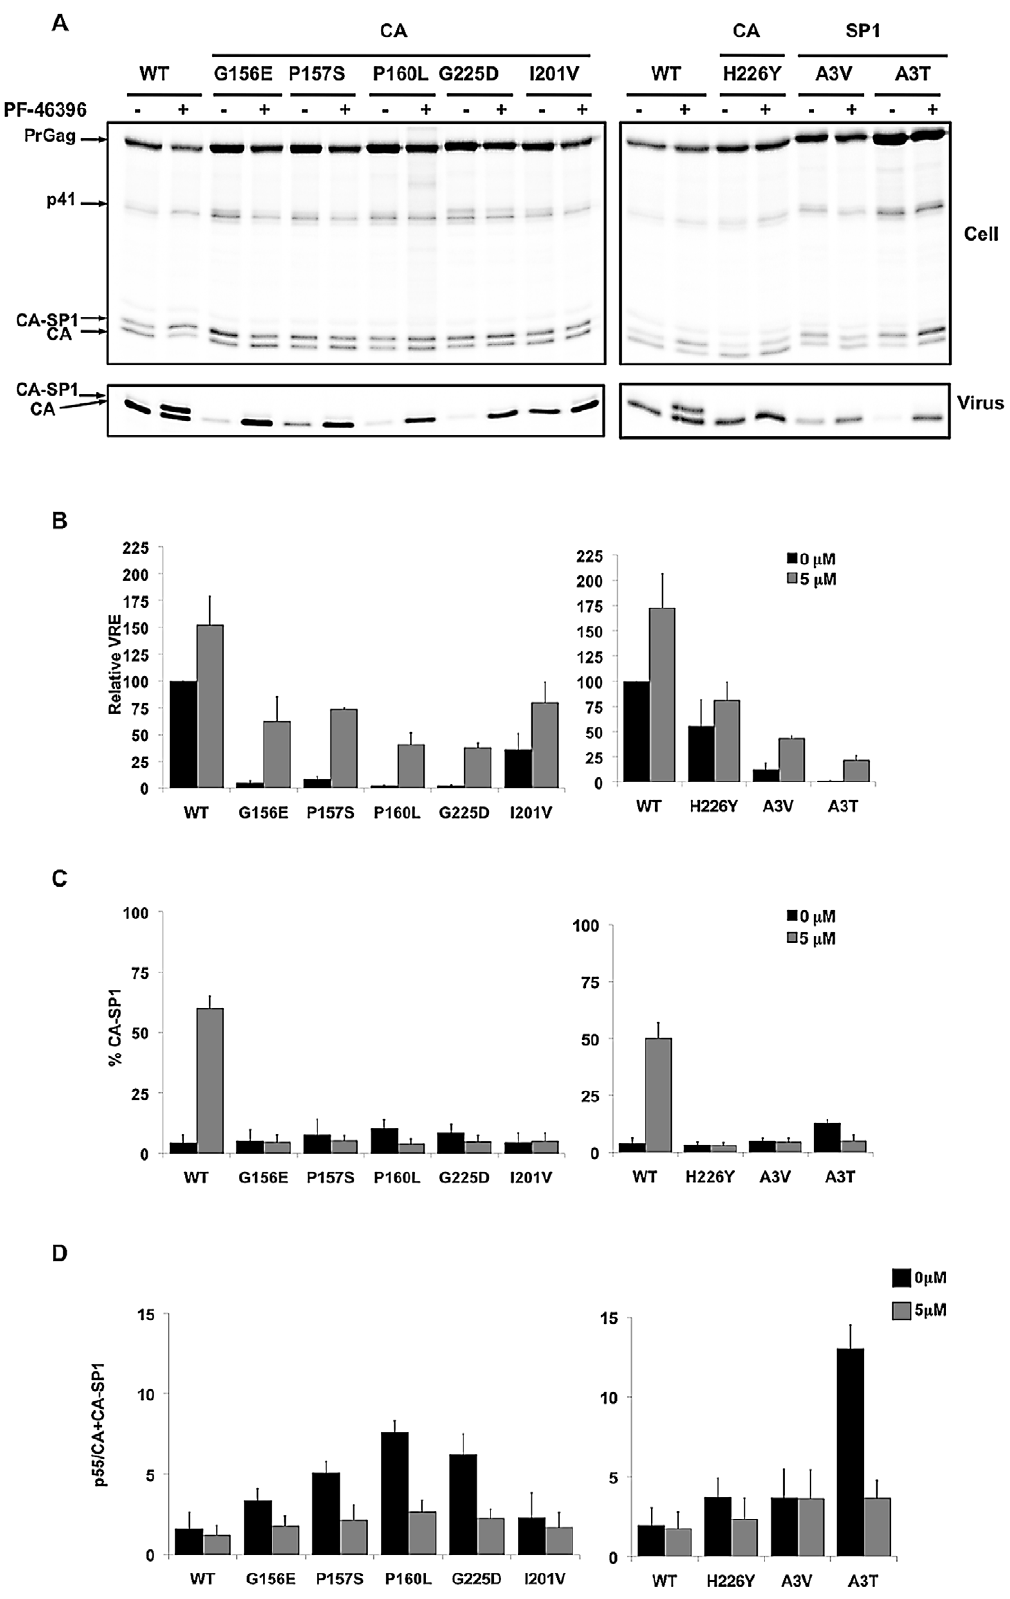
Figure 6. Characterization of PF-46396-resistant mutants. [A] Virus release and CA-SP1 processing in the presence or absence of PF-46396. 293T cells were transfected with WT or mutant pNL4-3 molecular clones, untreated ( 2 ) or treated ( + ) with 5 m M PF-463496 and metabolically labeled with [ 35 S]MetCys. Cell- and virus-associated proteins were radioimunoprecipitated. Positions of Pr55 Gag (PrGag), Pr41 Gag (p41), CA-SP1 and CA are